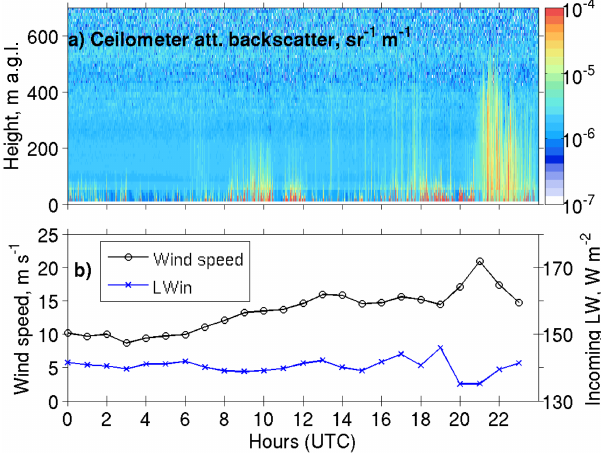
Figure 5. Cloud-free blowing snow event on 8 April 2013 (case 4): (a) 15s ceilometer raw attenuated backscatter profiles, and (b) hourly mean wind speed and incoming LW